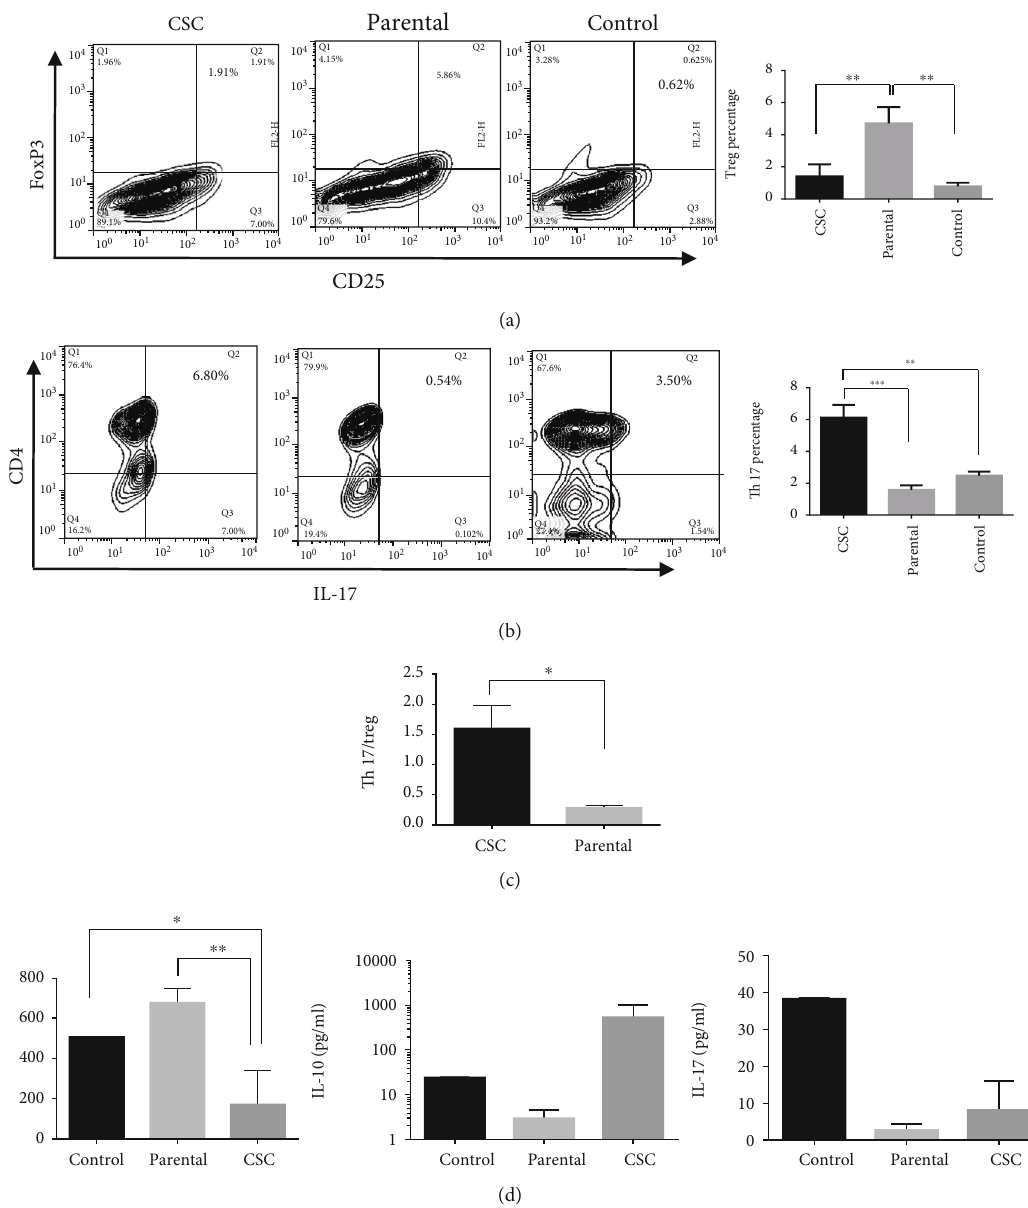
Figure 3: Di ff erentiation of Th17 and Treg after exposure to gastrospheres and parental-derived condition media in the presence of anti- CD3/CD28 microbeads. (a) CD4 + CD25 + FoxP3 + Treg cell di ff erentiation after exposure to gastrospheres or parental cell-derived condition media. (b) CD4 + IL-17 + Th17 cell di ff erentiation after exposure to gastrospheres or parental cell-derived conditioned media. (c) Th17 to Treg ratio after exposure to gastrospheres or parental cell-derived conditioned media. (d) Concentrations of IL-17, TGF- β , and IL-10 cytokines measured by ELISA in supernatants of PBMCs after being exposed to gastrospheres or parental cells ’ conditioned media. CSC: gastrospheres. Data are mean ± SD of three independent experiments. ∗ P < 0 : 05 , ∗∗ P < 0 : 01 , and ∗∗∗ P < 0 : 001